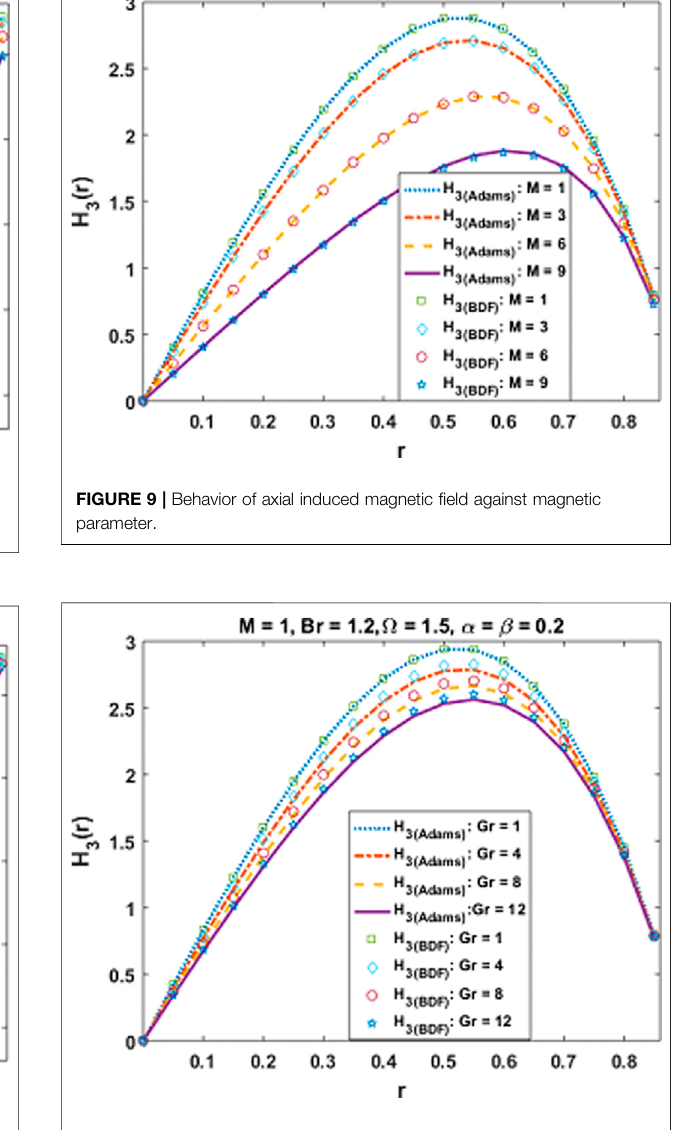
FIGURE 10 | Behavior of axial induced magnetic against Grashof